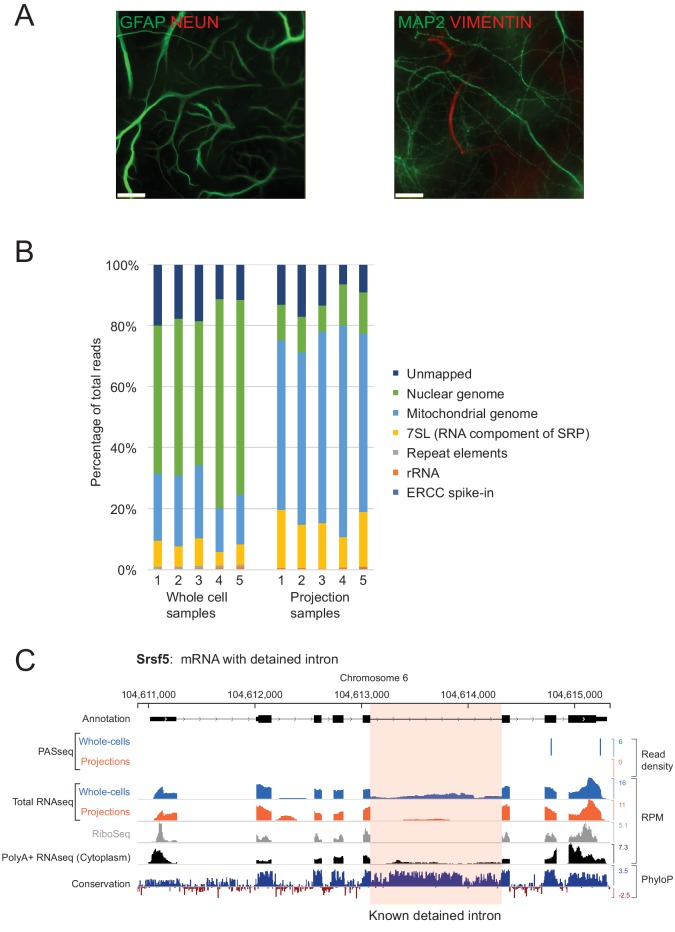
Separation of neuro-glial projections from cell bodies.(A) GFAP and Vimentin (VIM) immunopositive projections pass through the semipermeable membrane and are visible on the bottom surface by immunofluorescence imaging. (B) Percentage of total RNAseq reads from whole-cells and projections aligning to various genomic regions. A majority of reads from projection RNAseq data align to the mitochondrial genome. (C) Genome browser plot of read densities and sequence conservation for Srsf5, an mRNA with a known detained intron (highlighted in pink).